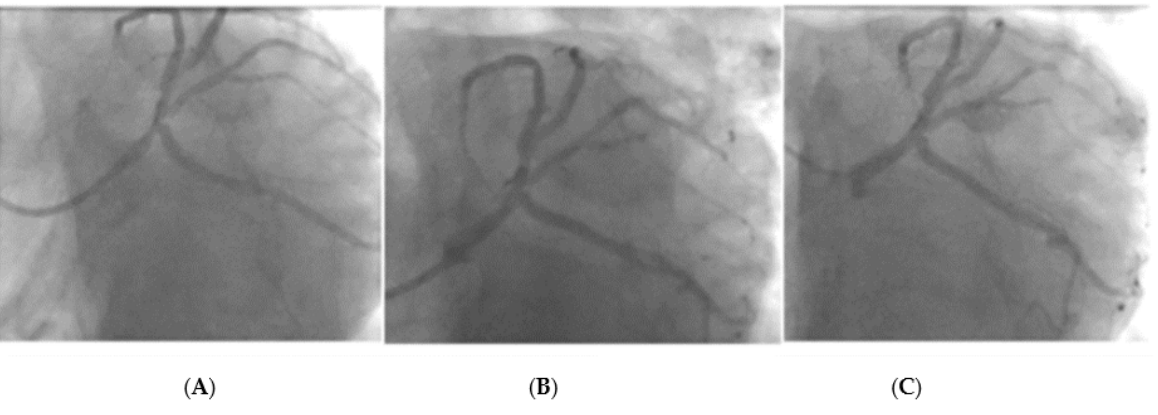
Figure 9. Left main stem DCB PCI with image ( A ): Pre PCI, Image ( B ): Immediately post PCI, Image ( C ): 6-month follow-up angiogram.